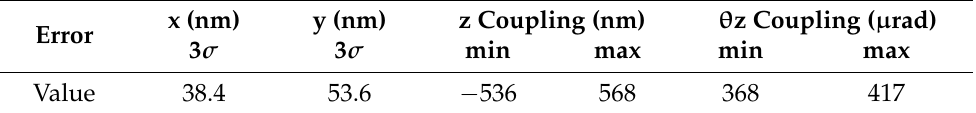
Figure 21. Tracking error of the in-plane trajectory and the coupling error. ( a ) x; ( b ) y; ( c ) z; ( d ) θ z. The tracking speed of the end-effector was set to 1.00 µ m/s, and the results using 3 σ ( σ , standard error) are shown in Table 10. Table 10. Tracking the two planed DOFs and coupling of two other